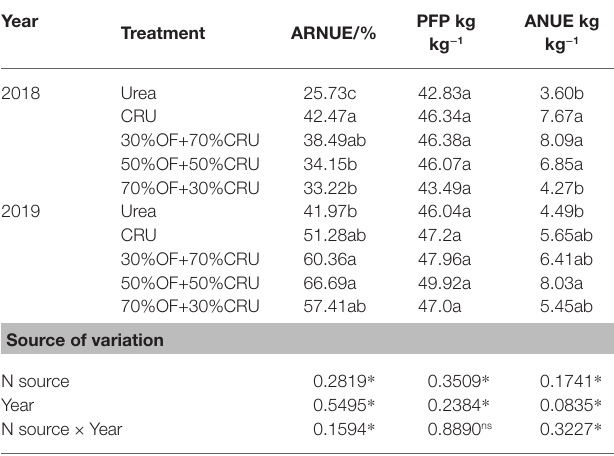
TABLE 2 | Nitrogen use efficiencies of wheat plants measured under different N application